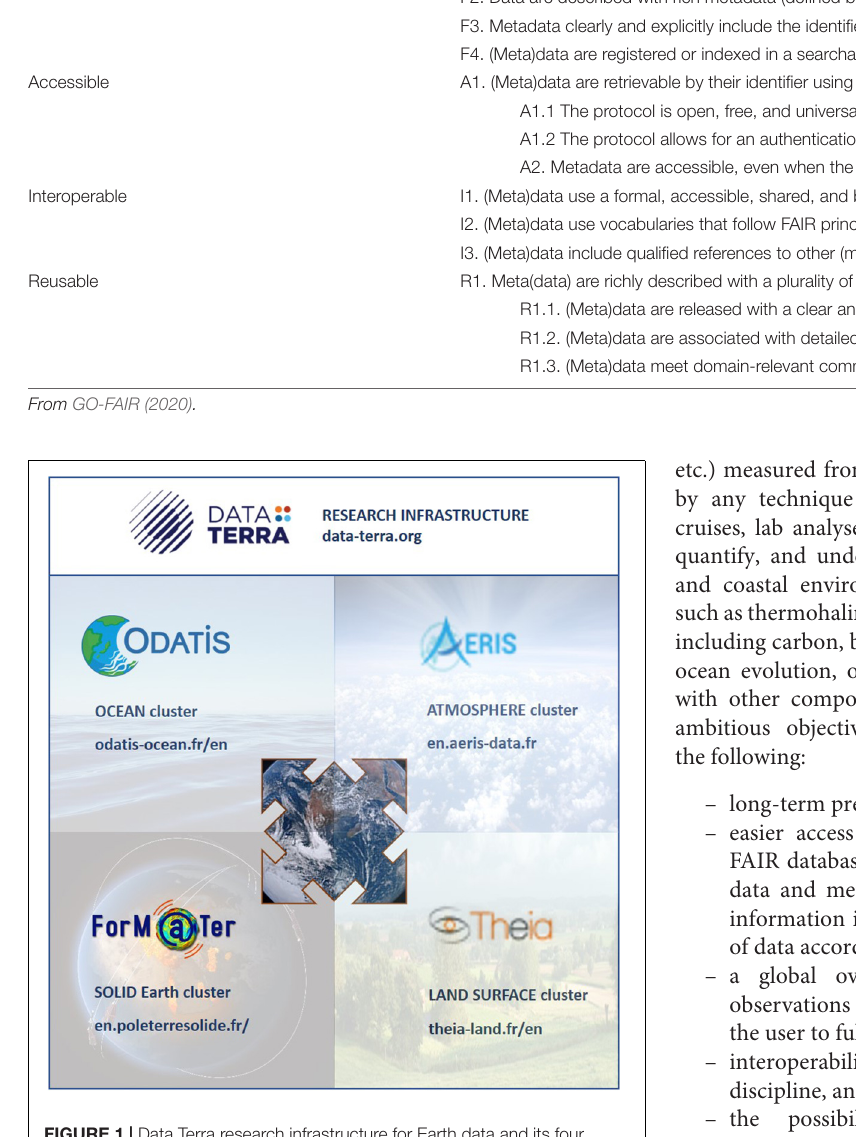
Terra also serves the international community through satellite missions, international monitoring networks, and partnerships for